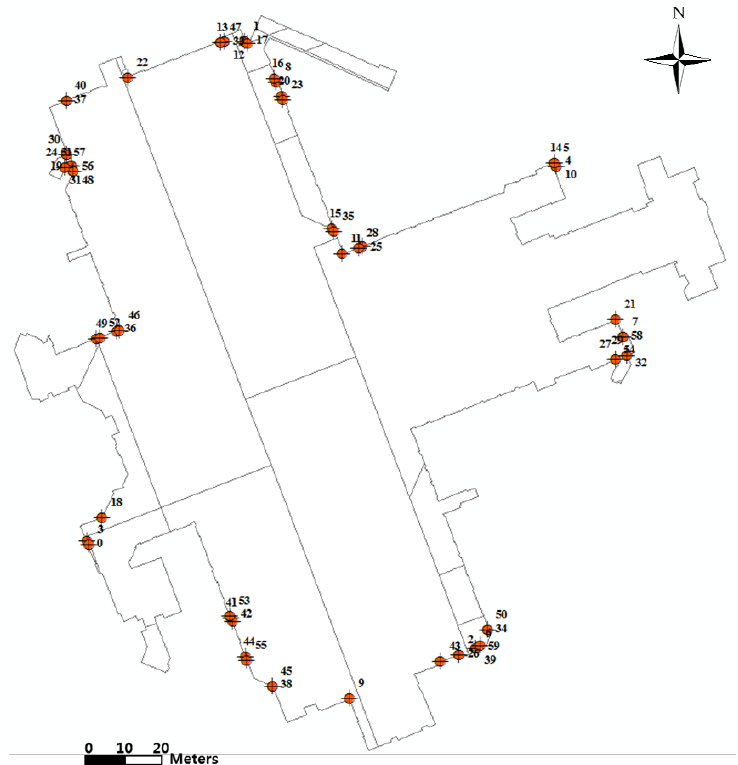
Figure 8. Distribution of 60 target points for accuracy assessment. Figure 9. Distribution of 60 target points for accuracy